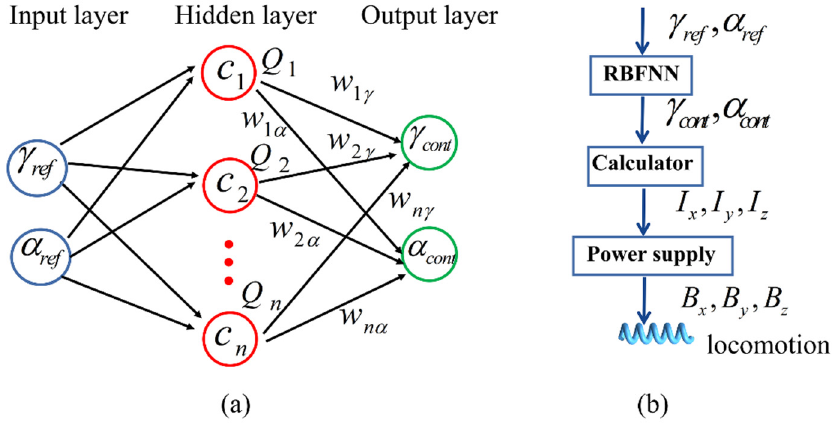
Figure 8. Scheme of RBFNN and control system: ( a ) structure of RBFNN for path tracking; ( b ) flow chart of control system.